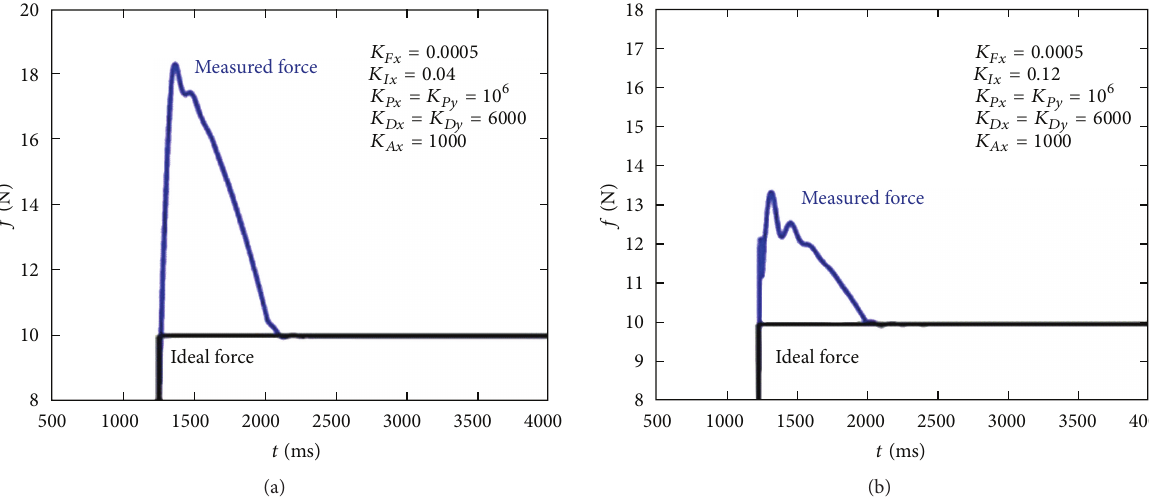
Figure 21: End-Effector force value (N) varying the 𝐾 𝐼 gain in the PI system: (a) 𝐾 𝐼 = 0.04 ; (b) 𝐾 𝐼 = 0.12